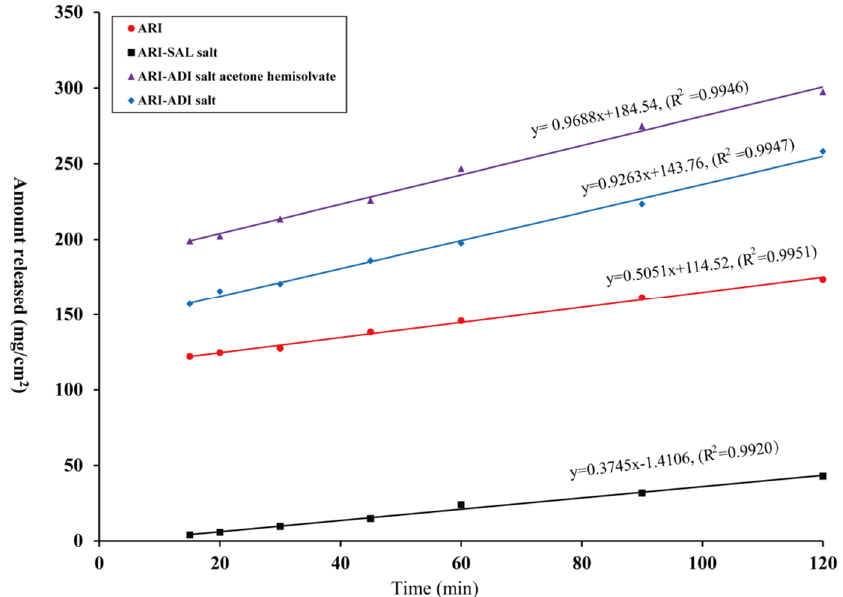
Figure 10. Intrinsic dissolution profiles of the ARI and its crystal salts in hydrochloric acid buffer (pH 1.2).